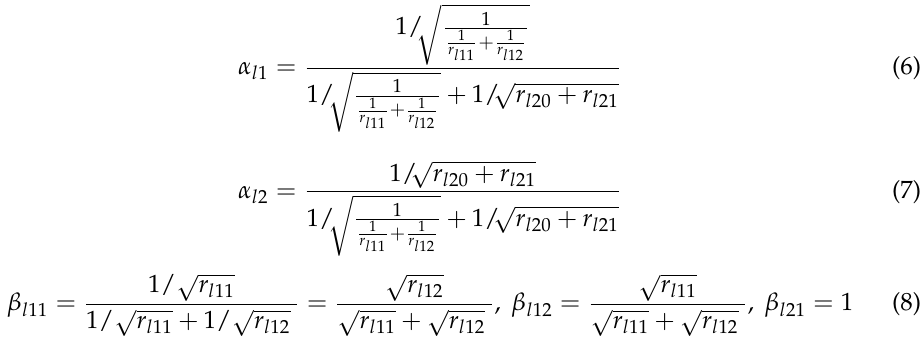
Figure 4. Wind farm numbering method to apply the algorithm.